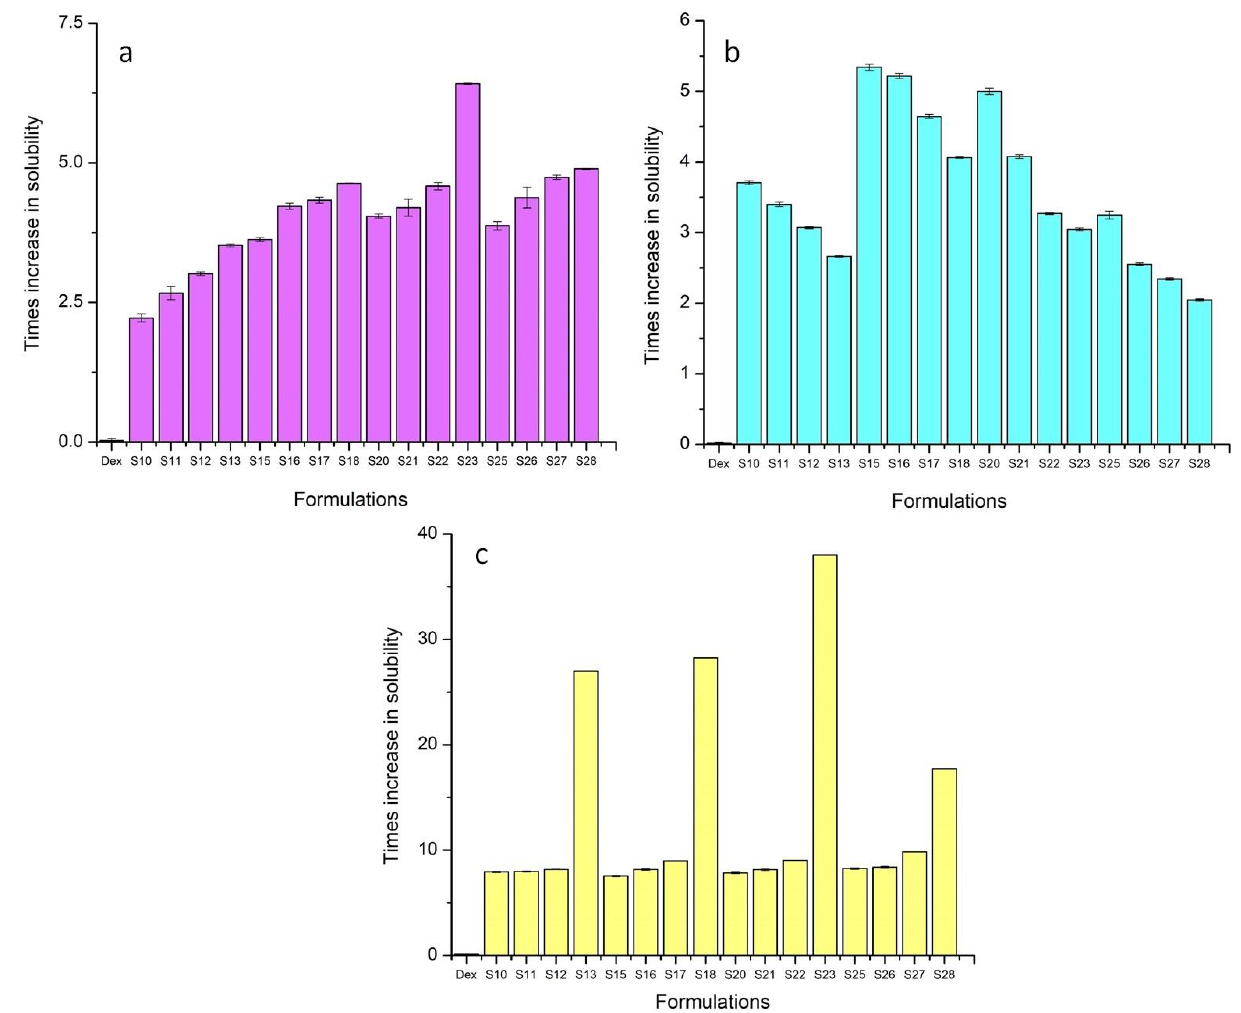
Figure 1. Solubility of TSD in ( a ) distilled water, ( b ) pH 1.2, and ( c ) pH 6.8. The error bar designates the standard deviation (n = 3).